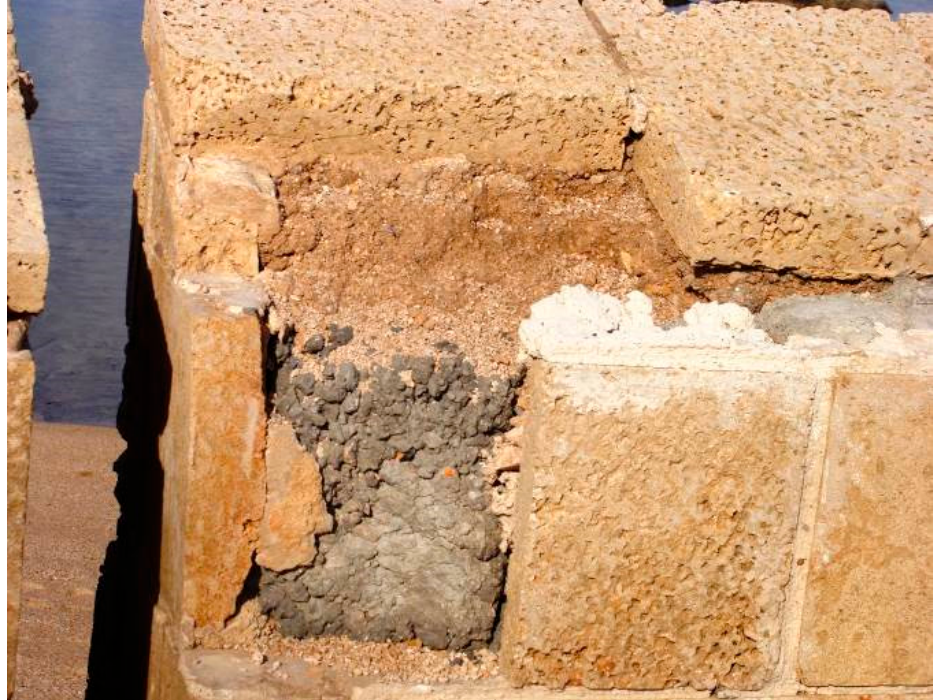
Figure 8. Break out of kurkar stone in the Panorama sea walls. Captured by the author on 27 November 2018. Figure 9. An efflorescence of kurkar siding in the Panorama sea walls. Captured by the author on 27 November 2018.